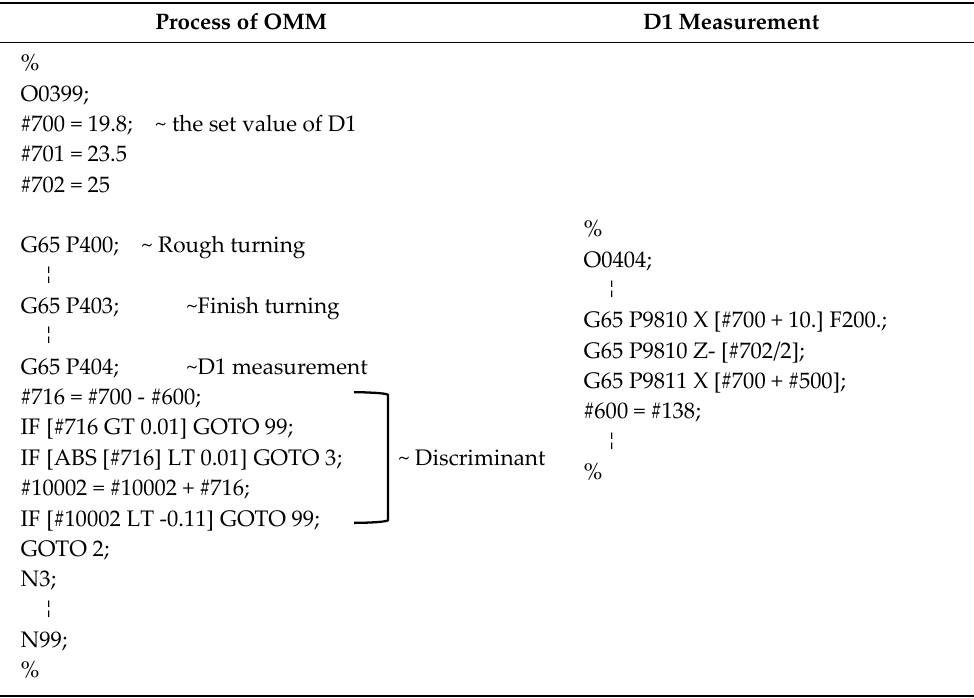
Table 1. Macro programming for on-machine inspection of D1 size.